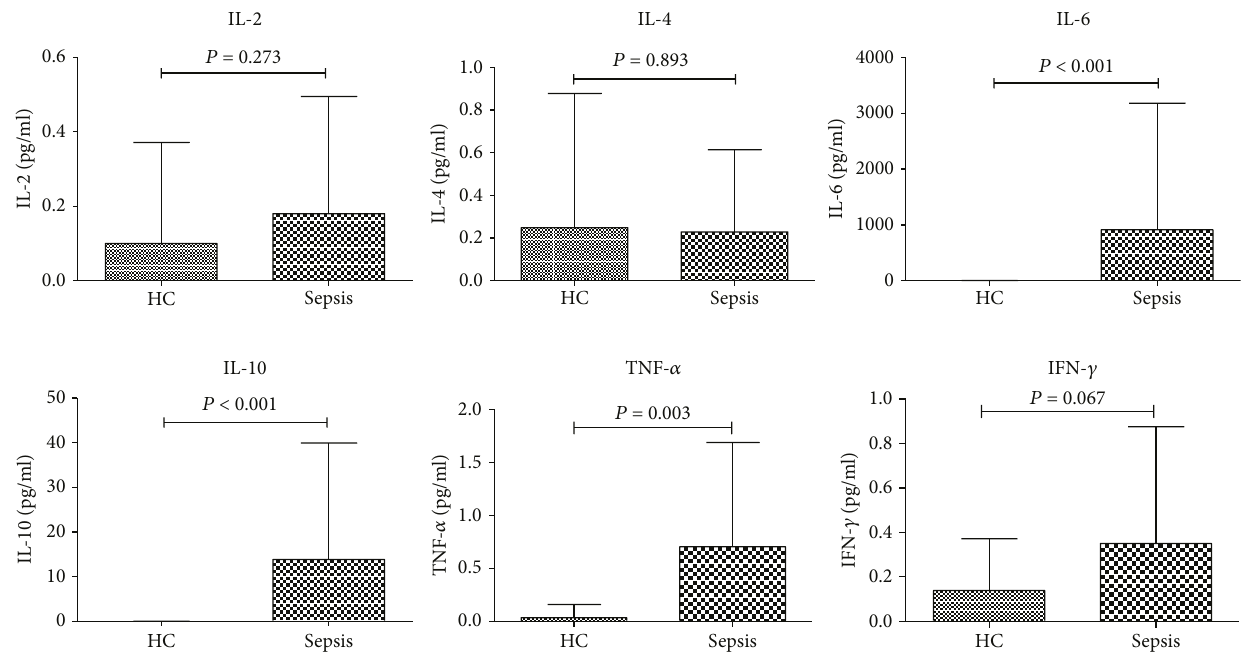
Figure 4: Content of serum cytokines in septic patients and normal